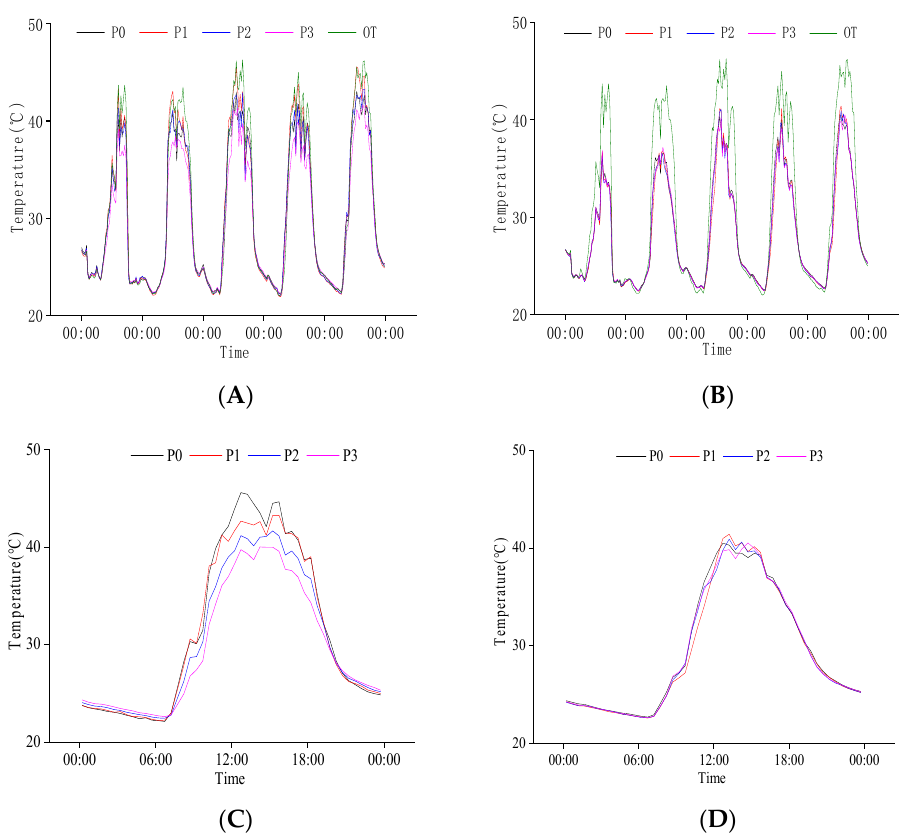
Figure 8. Daily variation in population temperature at the grain filling stage. ( A ) Canopy humidity of population from 16 August to 20 August; ( B ) Baselayer humidity of population from 16 August to 20 August; ( C ) Canopy humidity of population on 20 August; ( D ) Baselayer humidity of population on 20 August. OT is the change in external temperature, P0, P1, P2, and P3 are the effects of different nitrogen fertilizers on population temperature under N1 conditions.